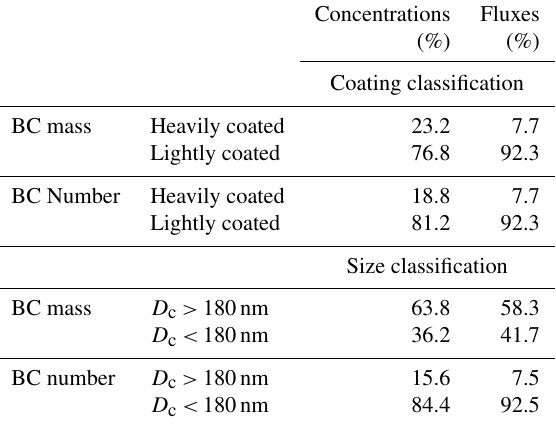
Table 2. Winter season percentage values of concentrations and fluxes for coating classification and size classification. For coating classification, the total particles were separated according to coat- ing contents using the threshold of E sca = 3 for both BC mass and number. For size classification, the total particles were separated at D c = 180nm, for BC mass and number. During summer, such an analysis was not performed due to limitations of the instrument at the time of the